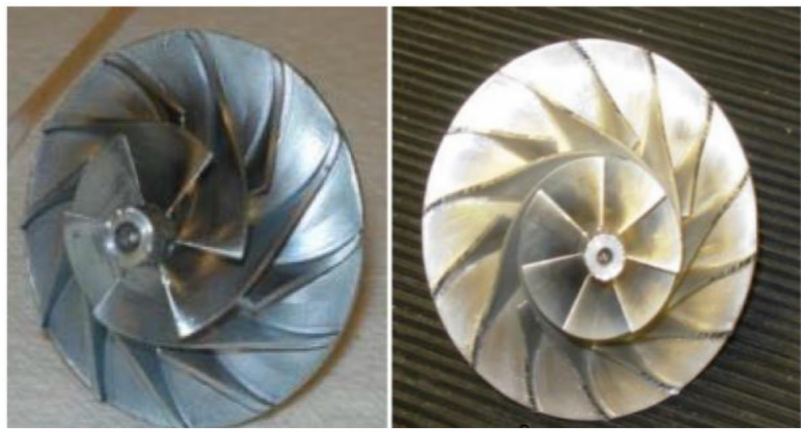
Figure 2. Sandia National Laboratories (SNL) test component